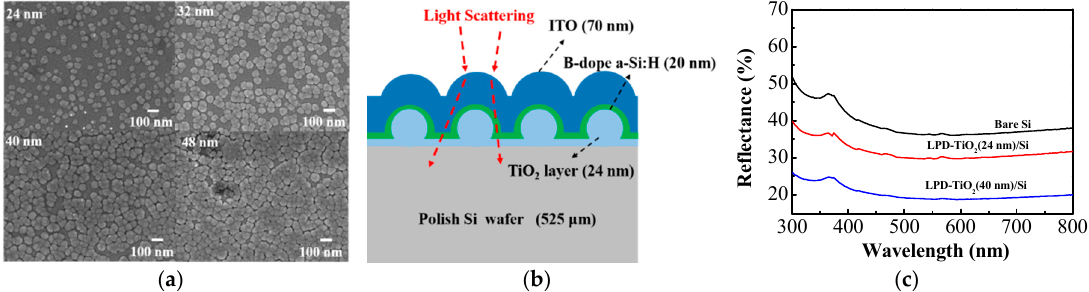
Figure 5. ( a ) Plan ‐ view scanning electron microscopy (SEM) images of LPD ‐ TiO 2 on Si; ( b ) proposed light scattering process in TiO 2 solar cell. The inset of ( c ) shows the measured surface reflectance of planar Si and LPD ‐ TiO 2 on Si.